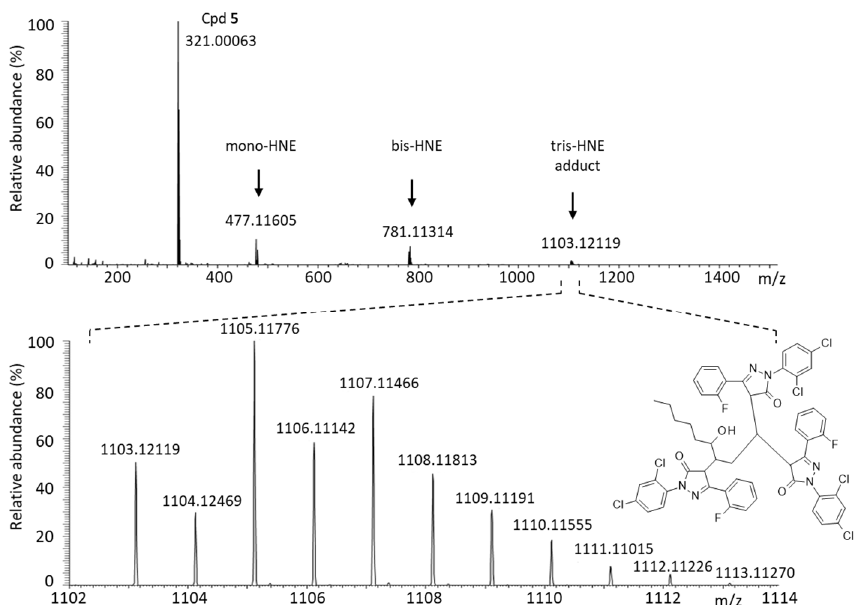
Figure 10. Identi fi cation of the covalent adducts formed upon reaction of compound 3 with 4-HNE by HRMS analysis. (Top spectrum) The unreacted parent product ( 3 ) and the di ff erent mono-, bis-, and tris-adducts are identi fi ed after 3 h of reaction in aqueous bu ff er (phosphate bu ff er 10 mM pH = 7.4, with stirring for 180 min at 37 °C). (Bo tt om spectrum) A detailed analysis of the 488–496 m / z range, corresponding to the mono-adduct (structure indicated).